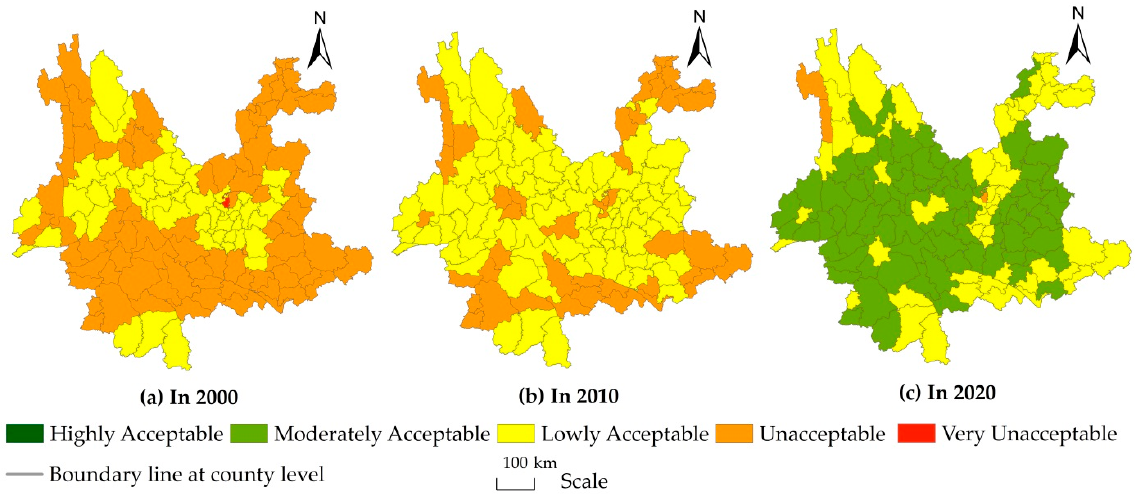
Figure 4. Economic viability evaluation of land use from 2000 to 2020.